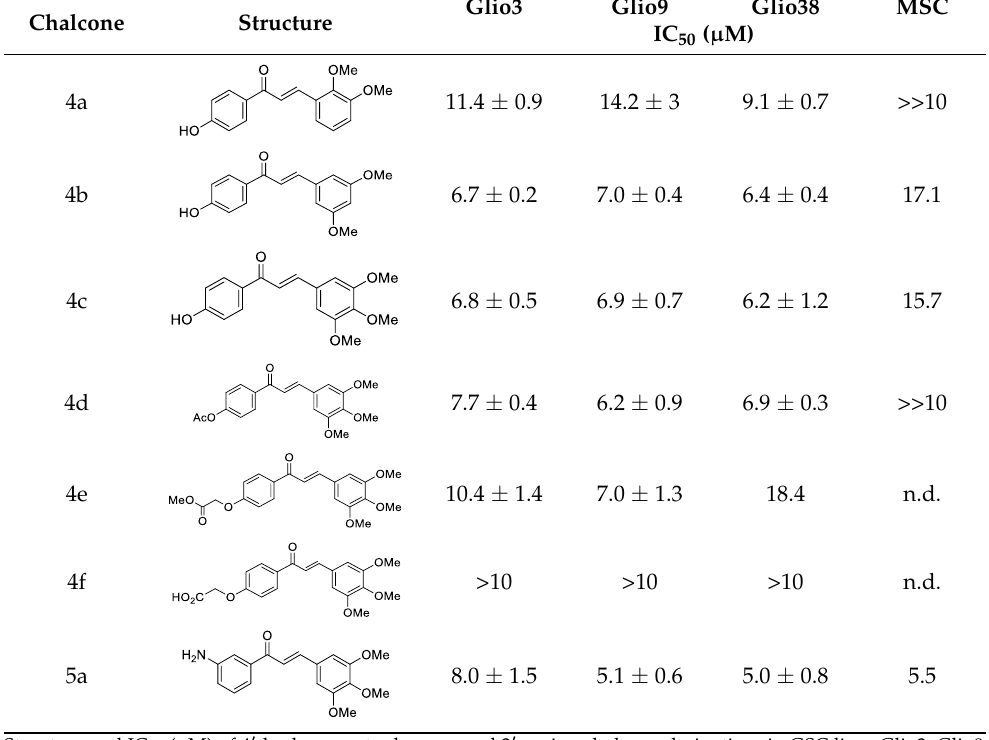
Table 2. IC 50 of 4′ -hydroxyacetophenone and 3′ -amino chalcone derivatives. Glio3 Glio9 Chalcone Structure Chalcone Structure Chalcone Structure